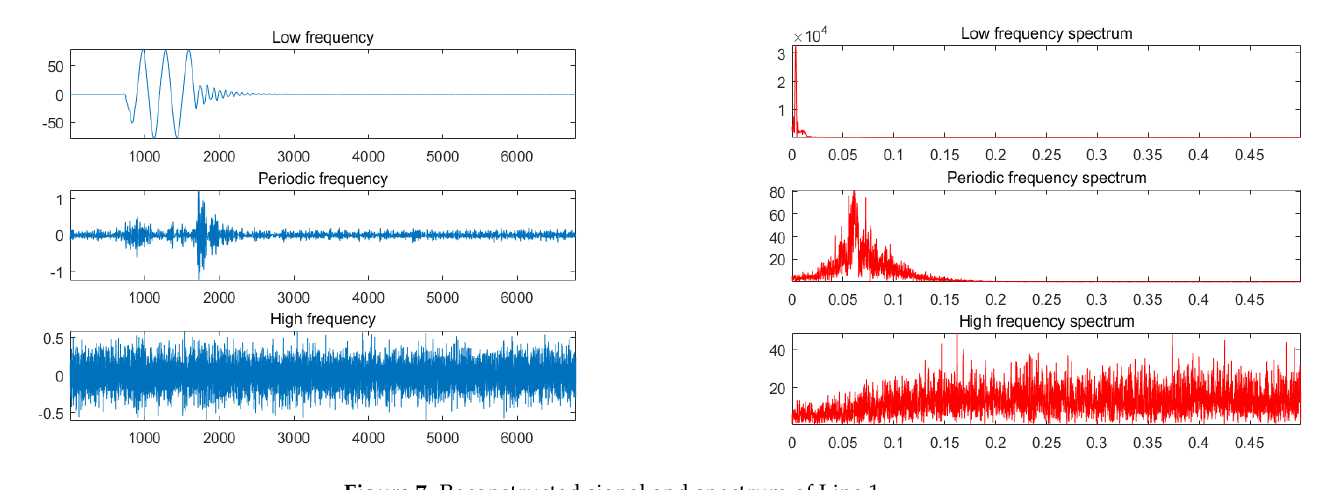
Figure 7. Reconstructed signal and spectrum of Line 1.